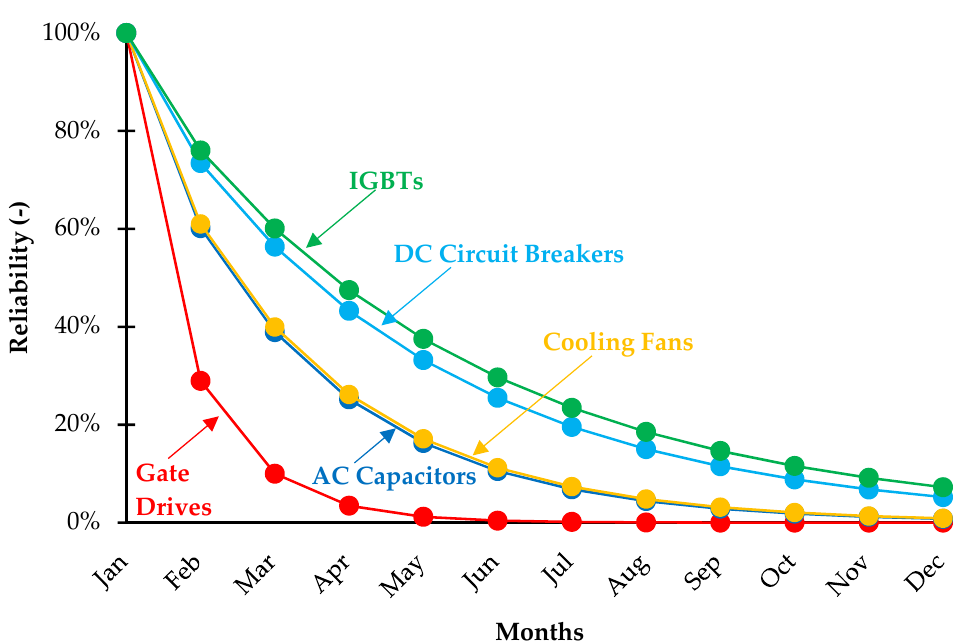
Figure 6. Reliability function of the DC/AC converter components using data from literature (first year of operation).